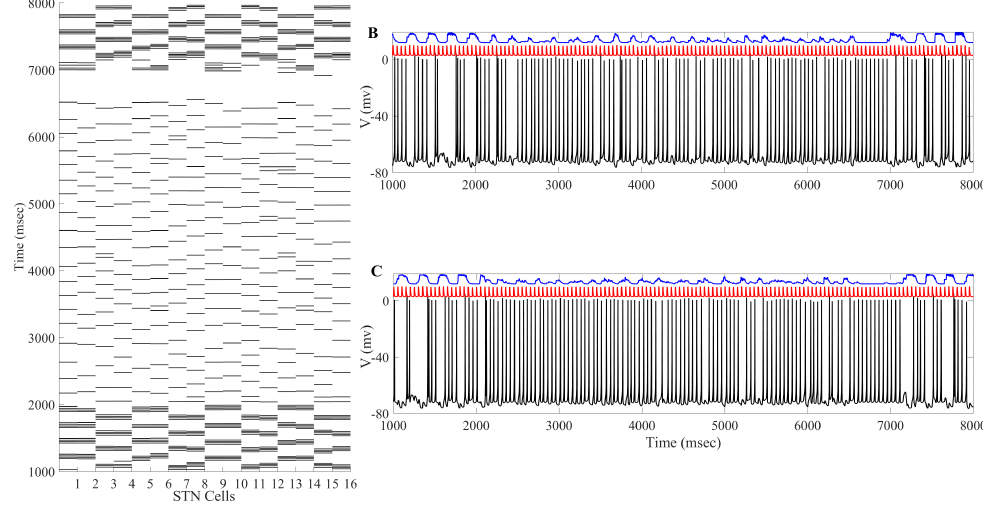
Figure 3. Example of acDBS. ( A ) Spike times of 16 STN neurons. acDBS is on from 2000 to 7000 ms with a 0 = − 16 and intt = 250 ms. Before stimulation, there are two synchronized clusters, as shown in figure panel (a) in Section 4.1.3. During the stimulation period, the bursting dynamic is largely eliminated, and the synchronized clusters no longer exist. Once stimulation is stopped, the synchronized clusters reemerge. ( B ) Relay performance of TC 1 . ( C ) Relay performance of TC 2 . In both ( B , C ), the top trace in blue is the total GPi synaptic input, the middle trace in red is the excitatory signal, and the bottom trace in black is the TC voltage. TC relay performance noticeably improves during the stimulation